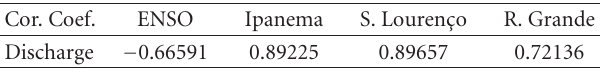
Table 2: Correlation coe ffi cients between ENSO and freshwater discharge and between discharge and water levels.